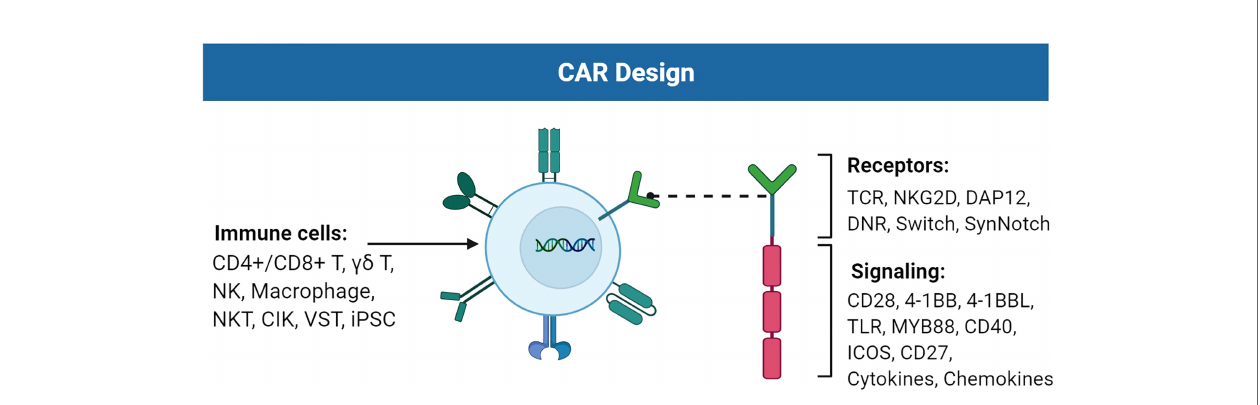
FIGURE 1 | Improvements of the chimeric antigen receptor (CAR) design. CAR consists of receptors and signaling suitable for TAA recognition and cell activation. Immune cells such as T cells, NK cells, and macrophages can carry CAR to perform cytotoxic activities against tumor cells. Figure created using